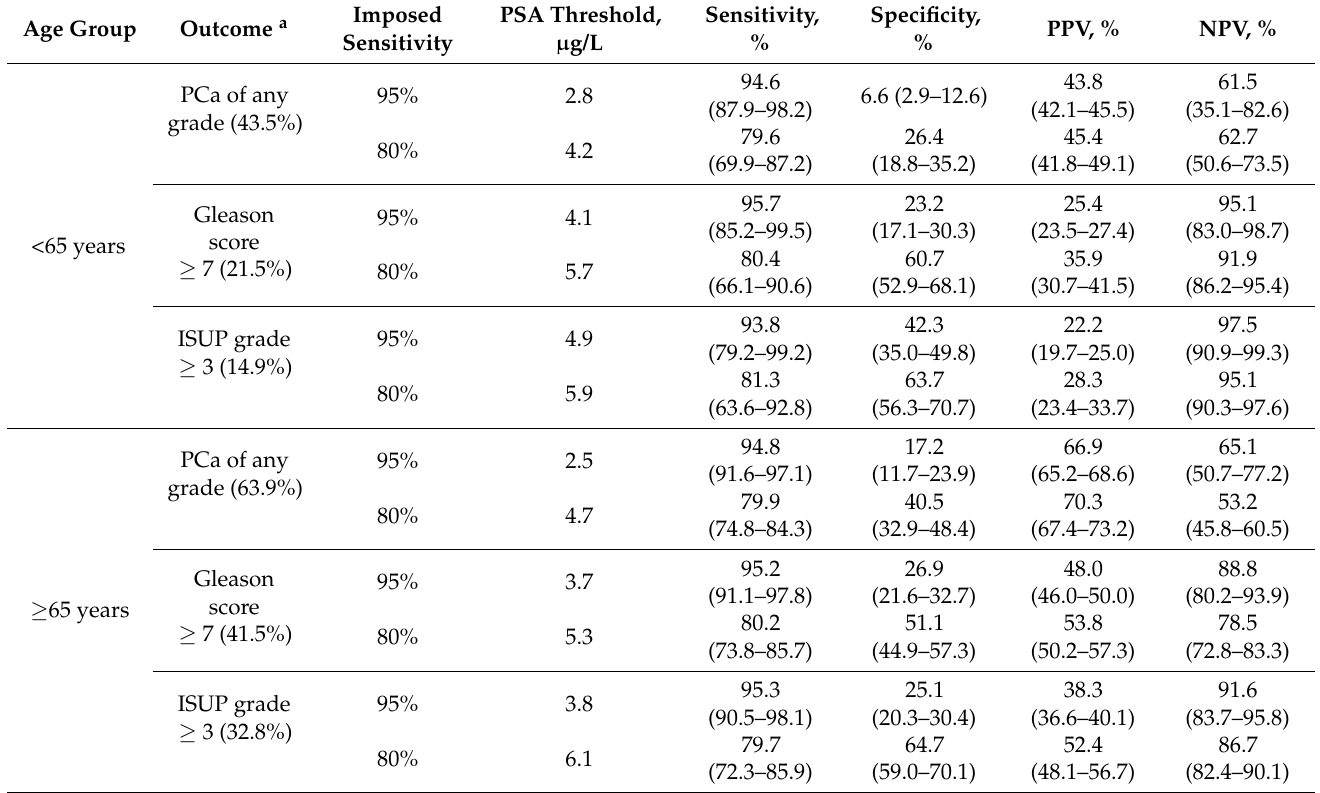
Table 3. PSA risk thresholds and estimated diagnostic parameters derived by assuming sensitivities of 95% and 80% for overall and advanced/poorly differentiated prostatic cancer (PCa) by considering only patients without histological evidence of glandular